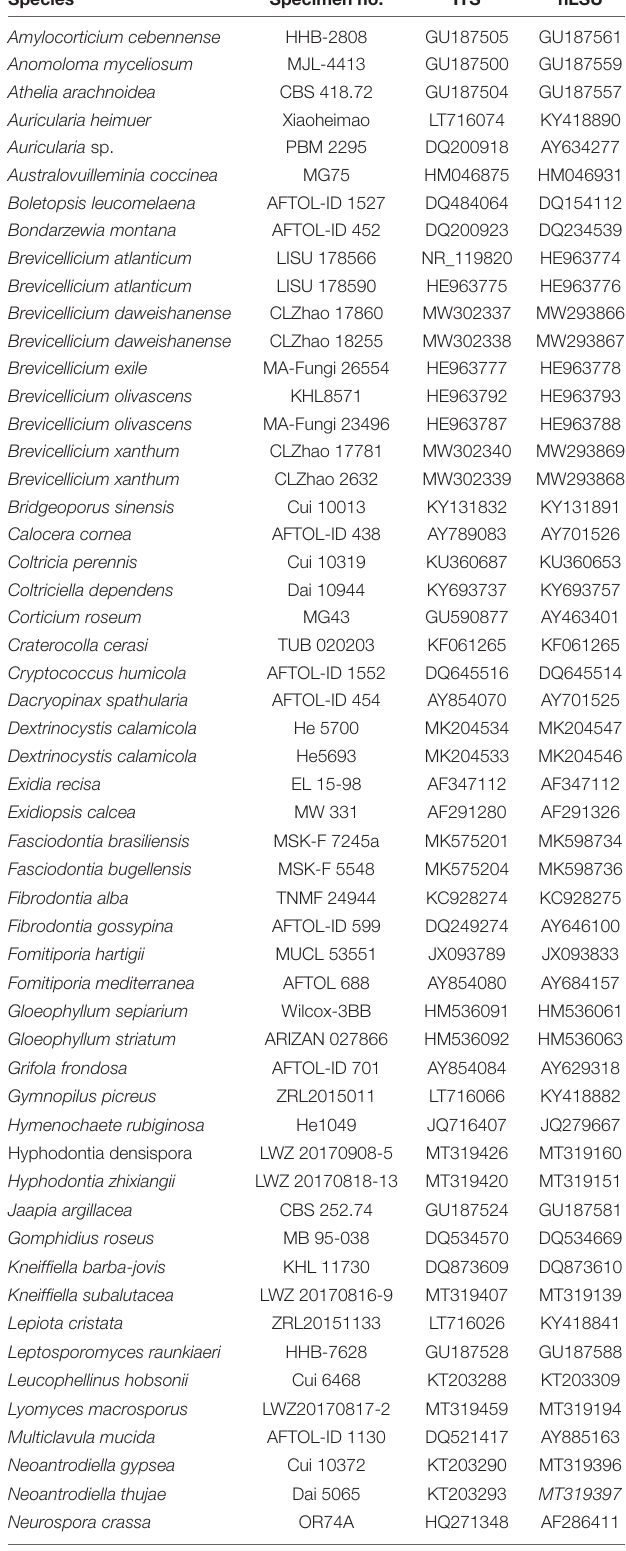
TABLE 2 | Information of taxa used in molecular clock analysis. Species Specimen